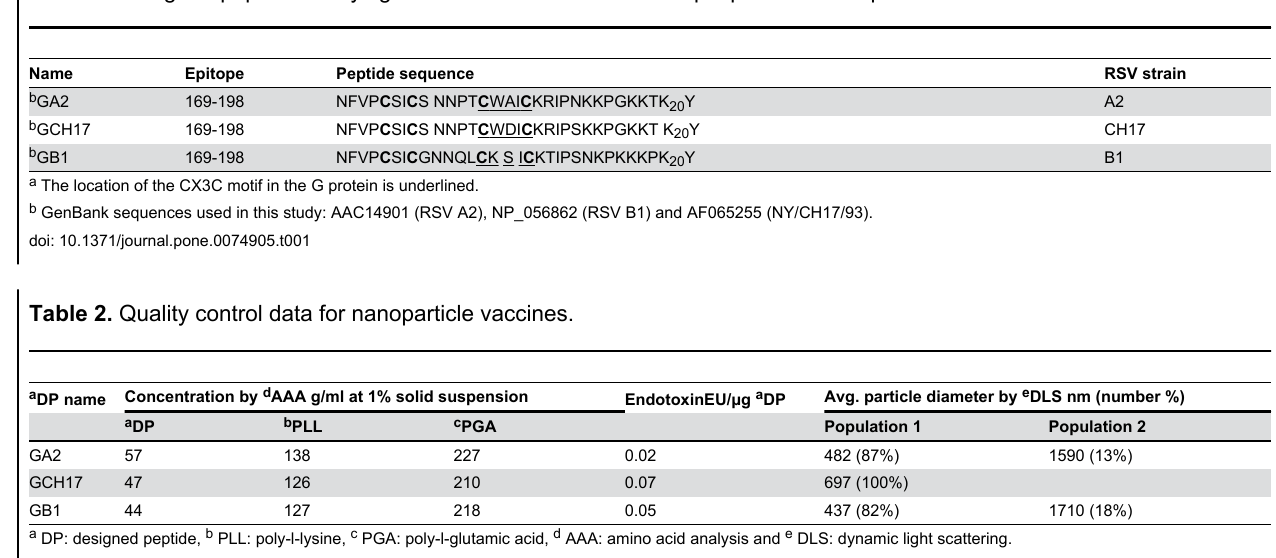
Table 1. Designed peptides carrying the CX3C chemokine mimic epitope a of RSV G protein.